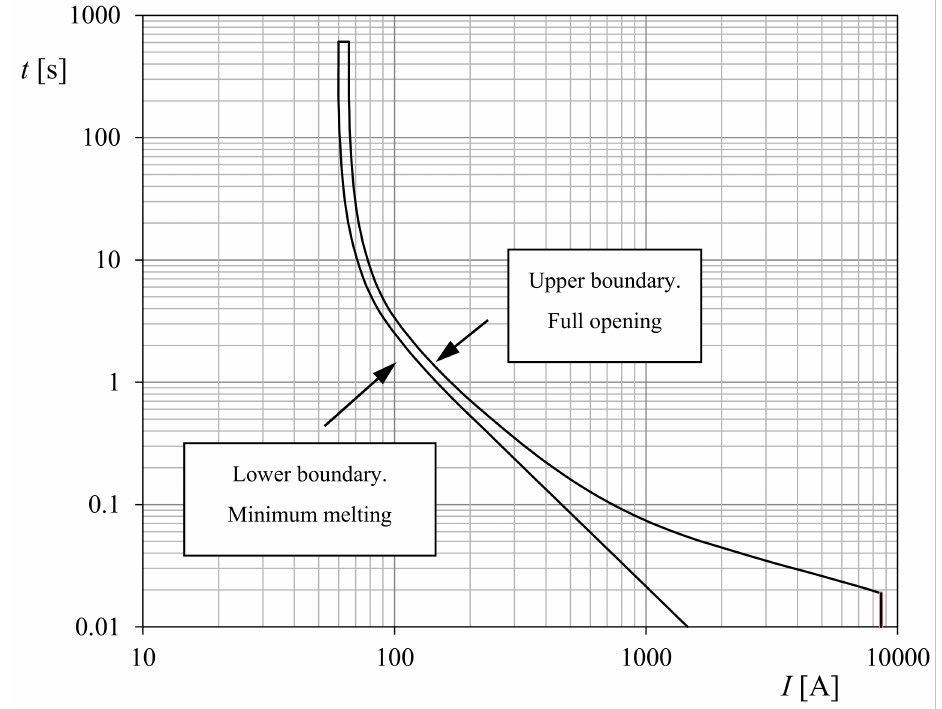
Figure 1. Tripping characteristic curve of an expulsion